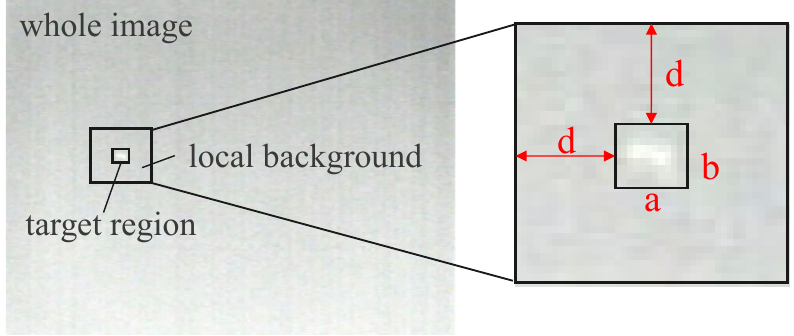
Figure 9. Local region of a small target in an infrared image.